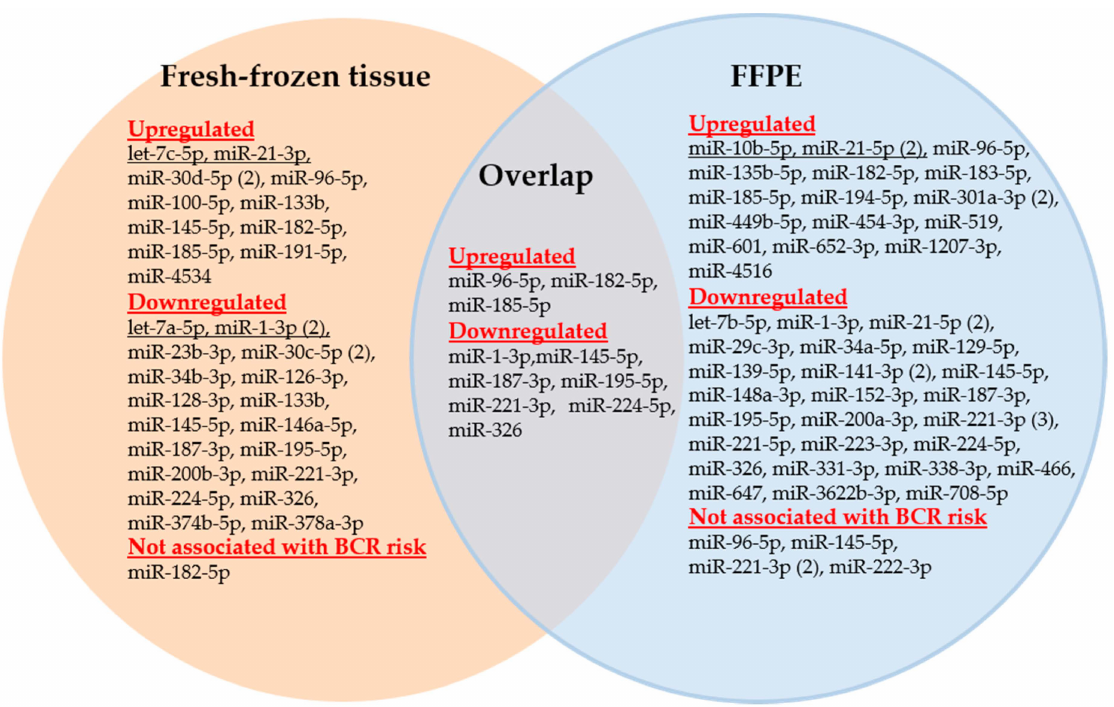
Figure 2. Venn diagram of the miRNAs analyzed in FFPE and fresh-frozen tissue samples of studies examining the predictive capability of miRNAs for biochemical recurrence. Numbers in parentheses indicate the number of studies that examined the respective